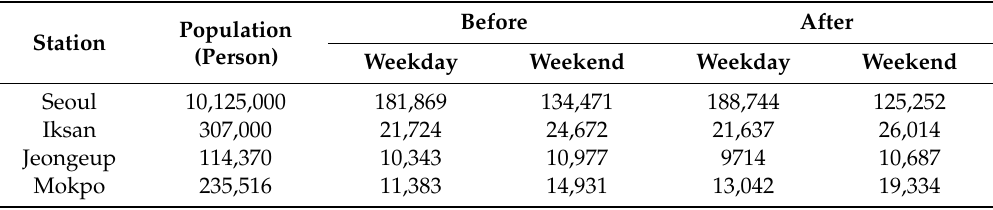
Table 3. Number of records of mobile phone data (averaged)